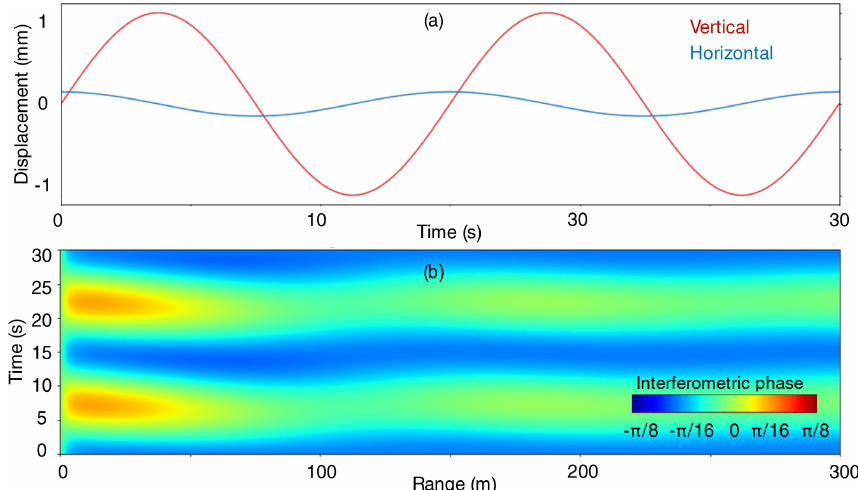
Figure A1. (a) Simulated vertical (red) and horizontal (blue) GPRI antenna motion as a result of waves ( T = 15s, A = 1mm, λ w = 150m, h = 2m). (b) Simulated interferogram of a floating GPRI system based on a propagating wave including antenna motion in panel (a) .